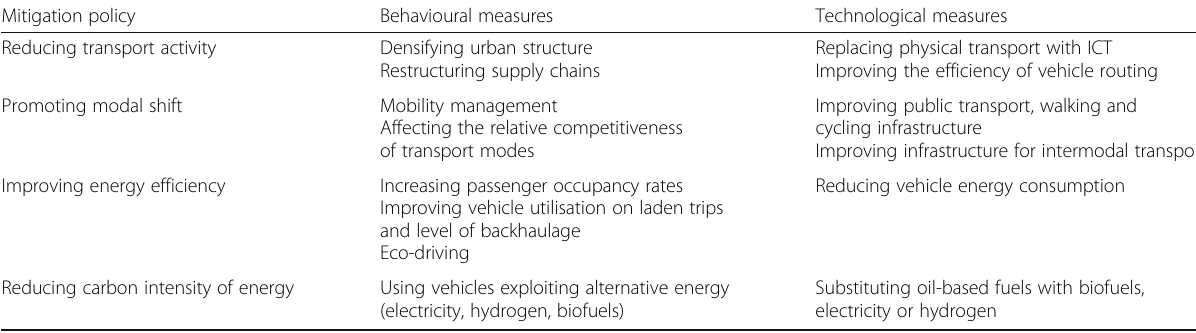
Table 1 Mitigation policies and examples of measures in passenger and freight transport (based on [23, 27, 37]) Mitigation